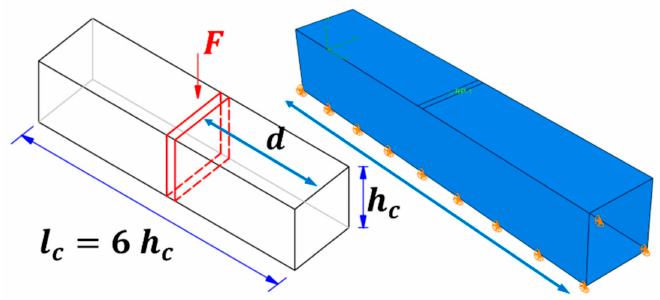
Figure 36. Reference finite element